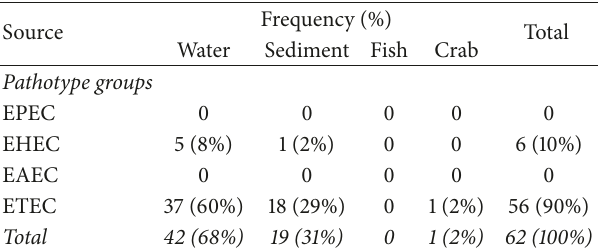
Table 3: Prevalence of E. coli